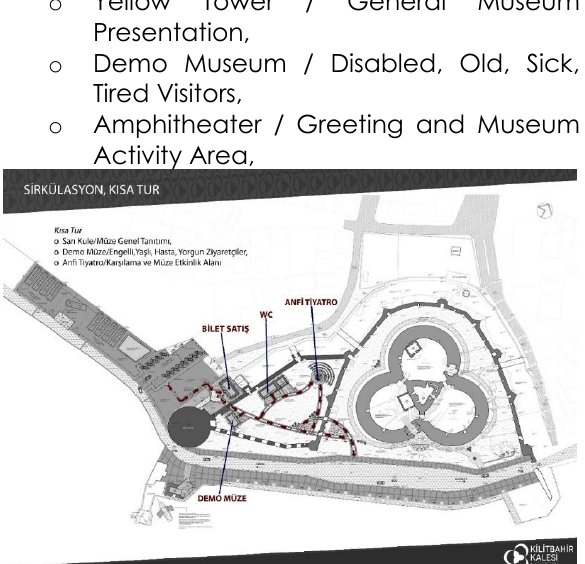
Figure 09: Kilitbahir Castle Site Plan-Short Tour Route, K.